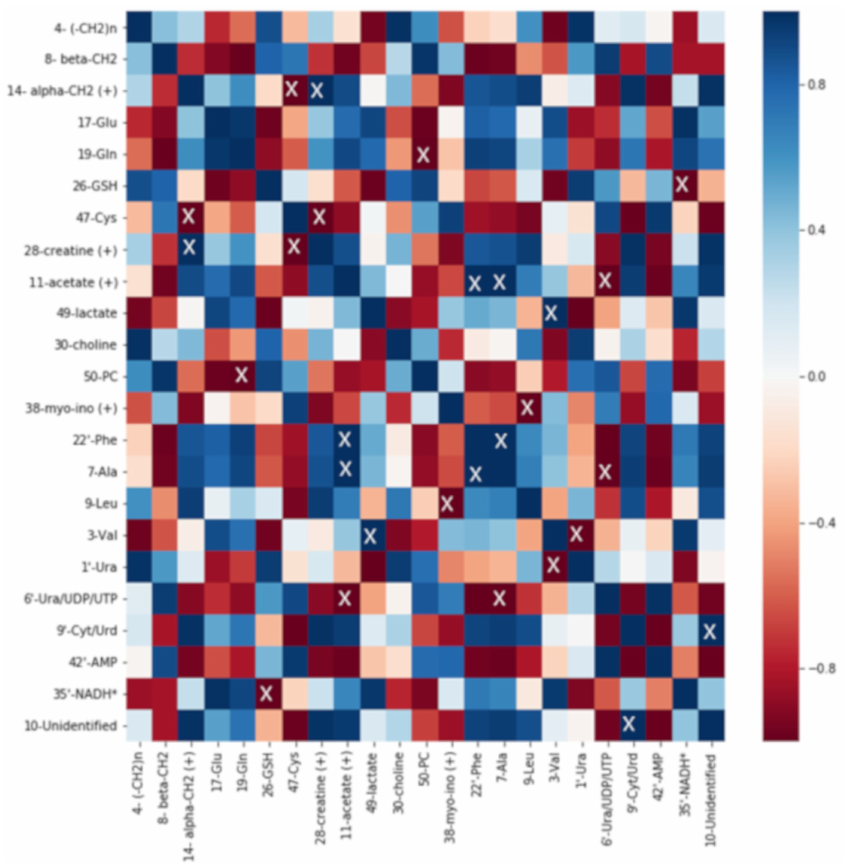
Figure 10. Heatmap of HEK-293 cells treated with 0.03 µ M of DiRu-1 vs. control: The blue color scale has been used for positive correlation, and the red scale is for negative correlation. “X” indicates significances with p -values < 0.05. * Tentative assignment. ( + ) stands for the possibility that some other metabolite is contained in the bucket in question in addition to the assigned